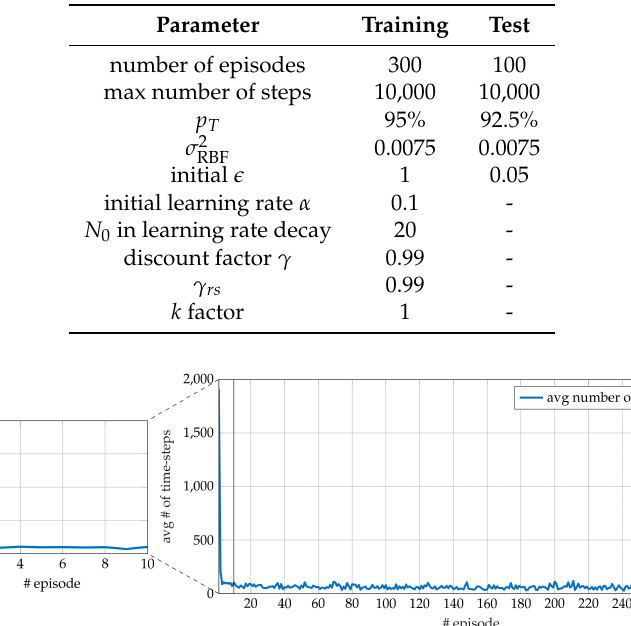
Table 1. Parameters used in EOS Q-learning.